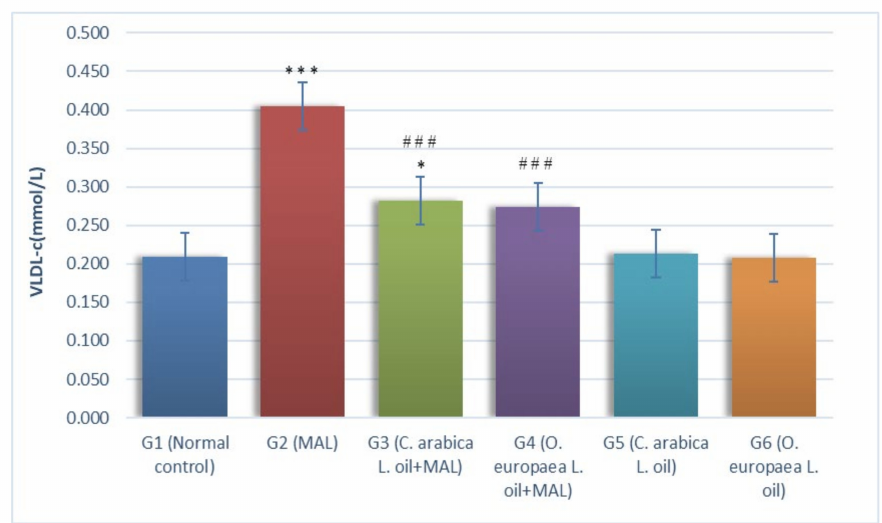
Figure 4. Influence of Coffea arabica L. oil and Olea europaea L. oil on the level VLDL-c. When a comparison was made against the normal control rats, a significant difference was found in the mean values at p ≤ 0.05 *; p ≤ 0.001 ***. When a comparison was made against the MAL-intoxicated rats, a significant difference was found in the mean values at p ≤ 0.001 ### .